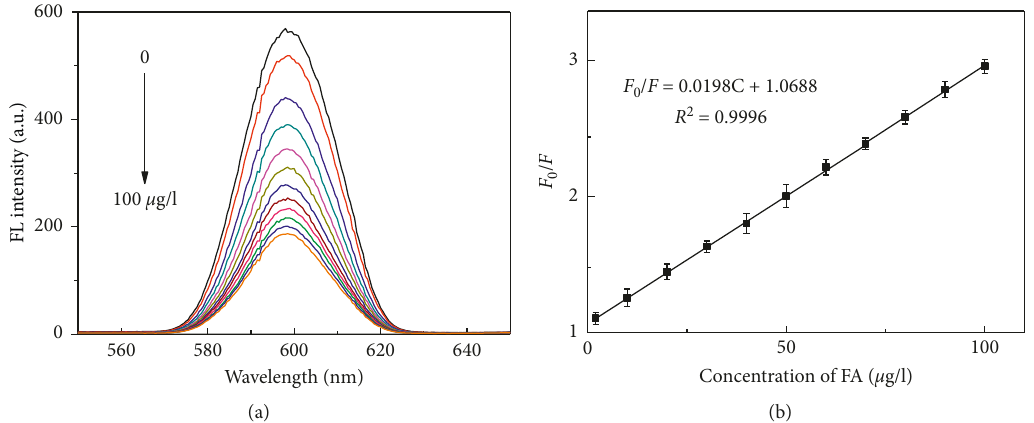
Figure 8: Fluorescence spectra of CdTe-QDs@MIPs in the presence of different concentrations of FA (2–100 μ g/l) (a) and the Stern–Volmer curve Table 1: Comparison of the developed method with other reported methods for FA determination. Detection scheme